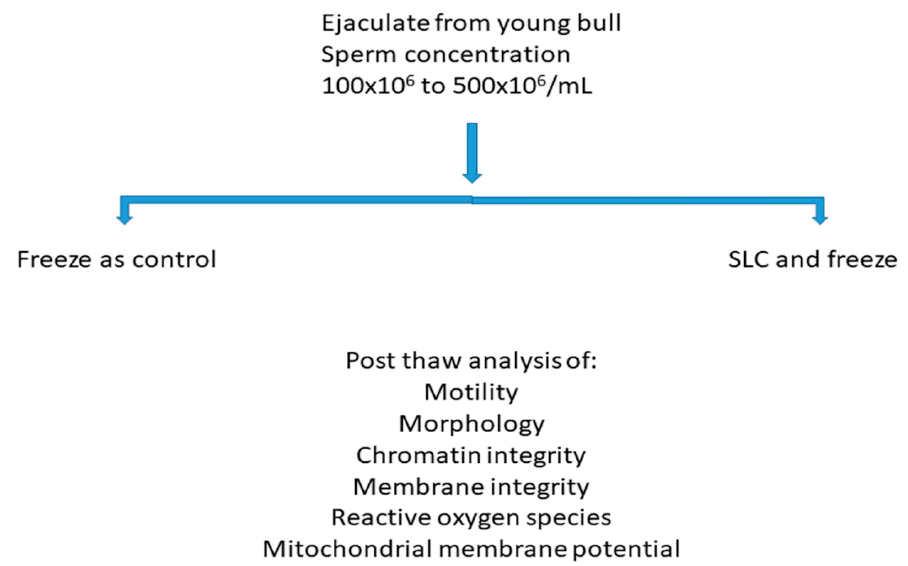
Figure 1. Experimental design. Note: SLC—Single layer centrifugation.